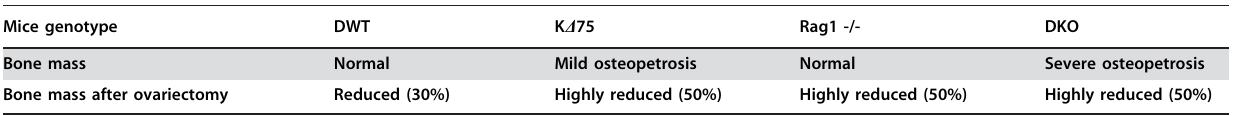
Table 1. Summary of bone mass phenotype in normal or ovariectomized 3-month-old female mice according to genotype .. ... .... ... ... .... ... ... .... ... ... .... ... ... .... ... ... .... ... ... .... ... ... .... ... ... .... ... ... .... ... ... .... ... ... .... ... ... .... ... ... .... ... ... . Mice genotype